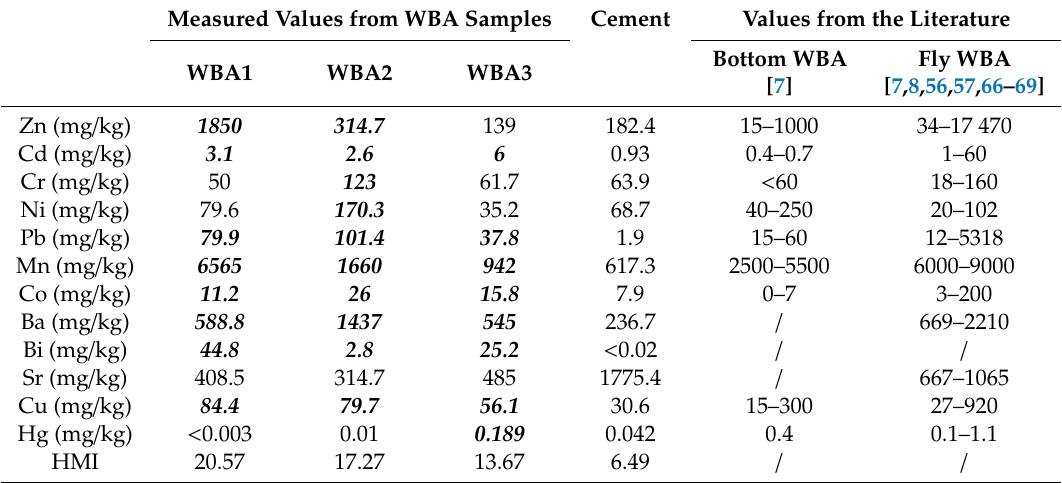
Table 2. Comparison of the heavy metals content (mg / kg) in the tested wood biomass ash (WBA) and cement, with heavy metal values for fly WBA and bottom WBA from literature [7,8,56,57,66–69].